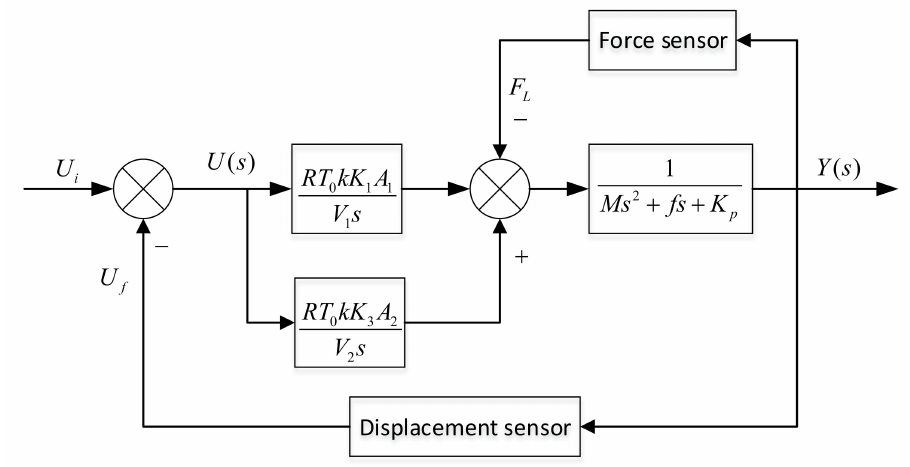
Figure 6. Block diagram of the closed-loop system of the pneumatic servo system.